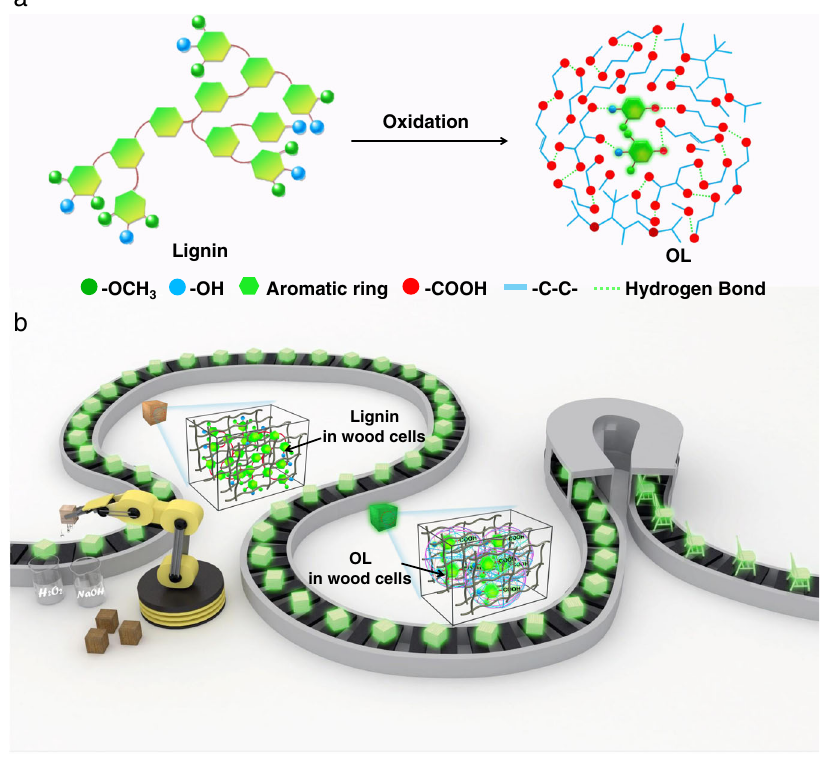
Fig. 1 | Schematic illustrating of lignin oxidation for RTP. a Design of afterglow materials from lignin via oxidation strategy. b Preparation of RTP wood and furniture from natural wood via an automatic